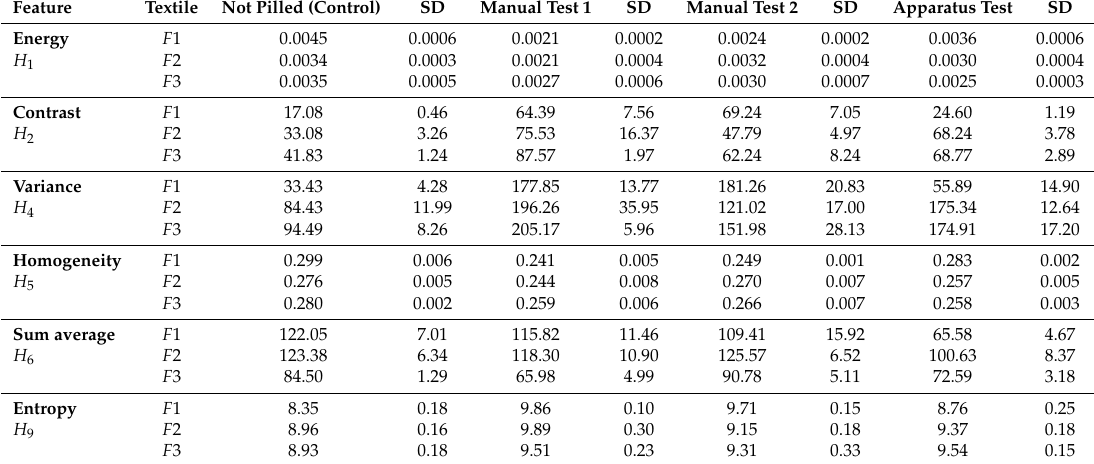
Table 3. Selected Haralick’s texture features extracted using GLCM of layer L P in the OCT image.